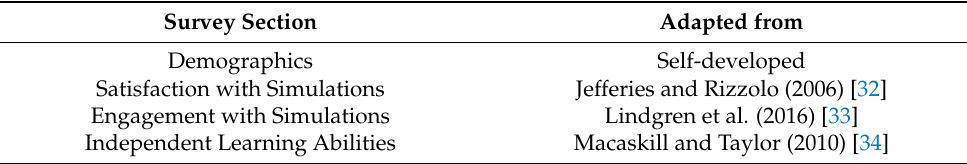
Table 1. Sections in survey questionnaire.